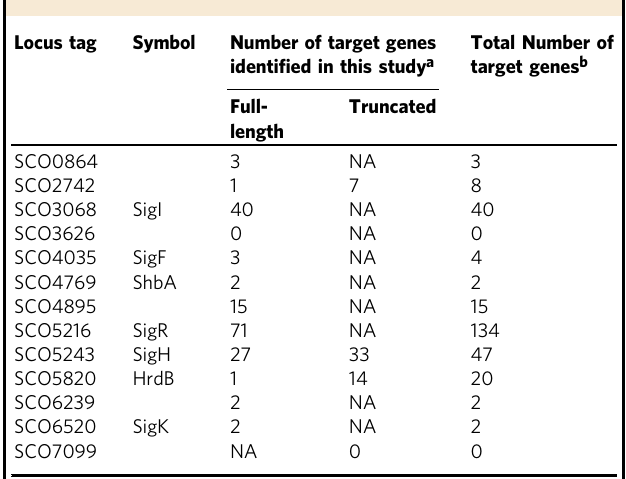
Table 1 Number of target genes identi fi ed.